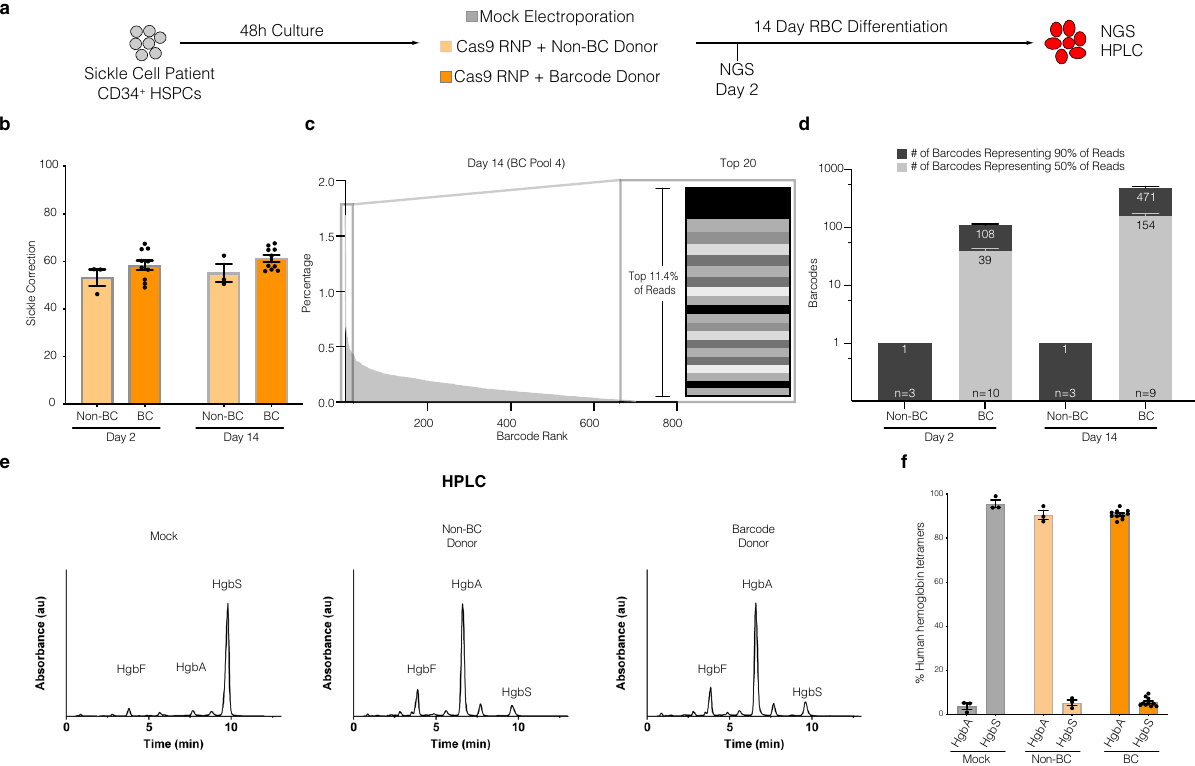
Fig. 2 Correction of the Sickle Cell Disease-causing E6V mutation using barcoded AAV6 donors in SCD-derived CD34 + HSPCs. a Experimental design – SCD patient-derived CD34 + HSPCs edited with CRISPR/Cas9 RNP and electroporation only (mock), single donor (non-BC), or barcode donor (BC) AAV6 HR templates. b SCD correction ef fi ciency (percentage of corrected sickle cell alleles) of non-BC and BC treated groups as a fraction of total NGS reads (e.g., HR reads / [all reads].) n = 3 (non-BC) and n = 10 (BC) biologically independent replicates examined over 3 independent experiments. c Representative example of barcode fractions in descending order from one donor at day 14 time point. Right: Top 20 clones represented as stacked bar graph (representing 11.4% of reads). d Number of unique barcode alleles comprising the top 50% and top 90% of reads from each treatment condition, sampling approximately 1000 cells per condition (see Supplementary Tables 1 and 2). e Representative hemoglobin tetramer HPLC chromatograms of RBC differentiated cell lysates at day 14 post-treatment. f Quanti fi cation of total hemoglobin protein expression in each group. Each data point represents an individual biological replicate. n = 3 (Mock and non-BC) and n = 10 (BC) biologically independent replicates examined over 2 independent